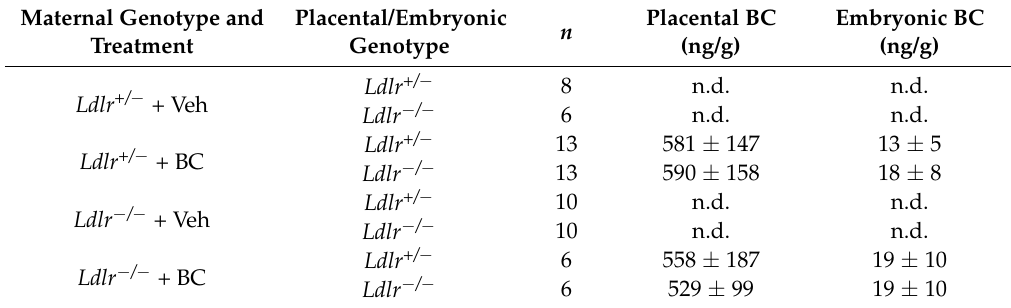
Table 3. β -carotene in the placentas and embryos of Ldlr +/ − and Ldlr − / − pregnant mice administered β -carotene. Maternal Genotype and